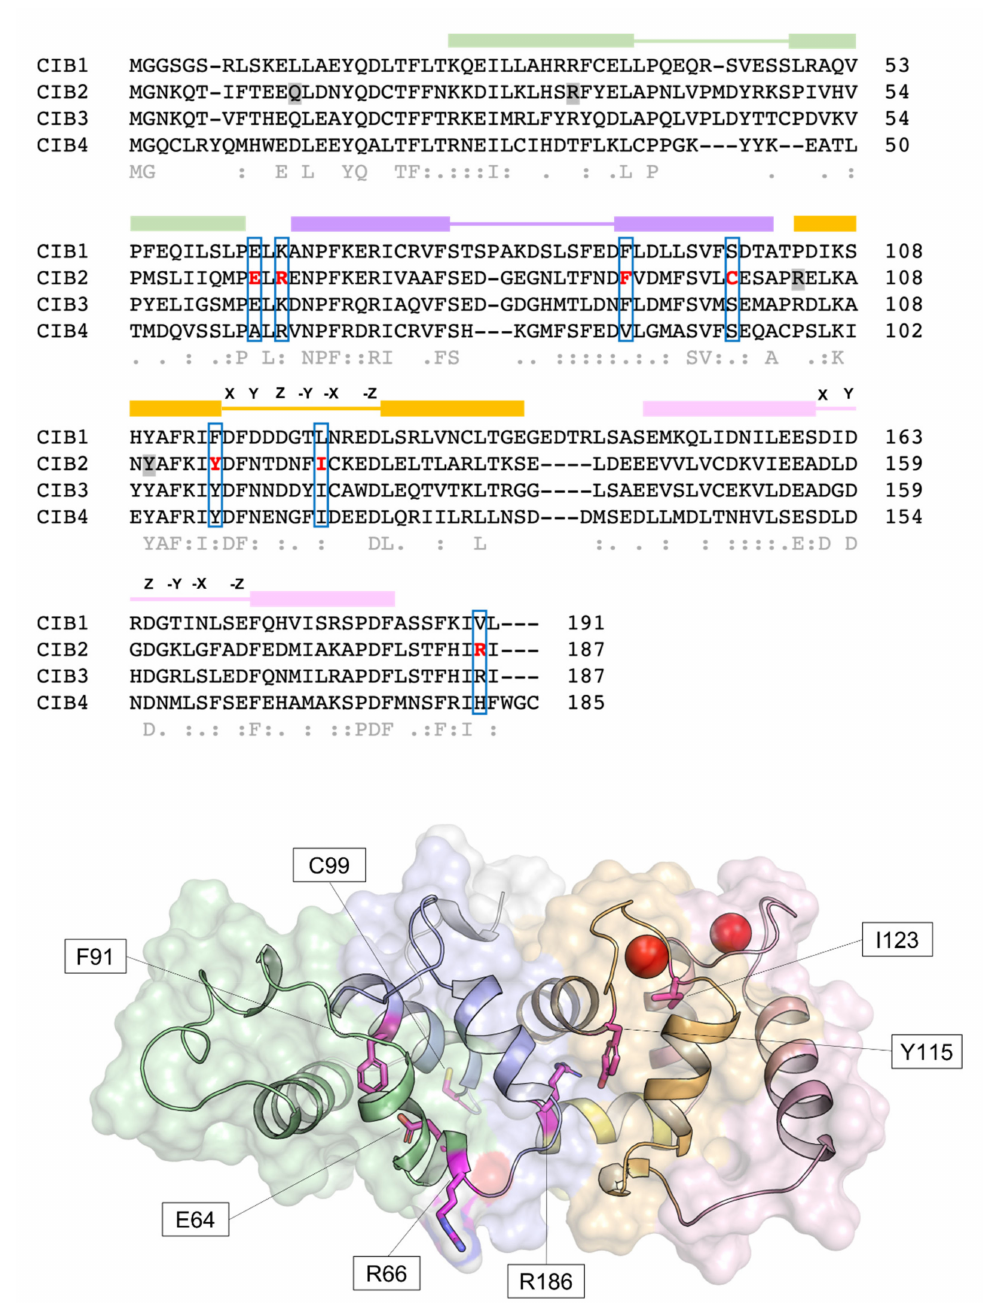
Figure 1. Sequence and structural properties of CIB2 and its pathogenetic variants. Top: multiple amino acid sequence alignment of human CIB1, CIB2, CIB3, and CIB4 performed by T–Coffee (https://tcoffee.crg.eu/apps/tcoffee/index.html, accessed on 22 February 2022). Consensus sequence and similarity descriptors are reported in grey text. Residues target of pathogenetic point mutations are grey-shaded in case of nonsense mutations or marked in red and blue-boxed in case of missense mutations (see Section 4.3). EF-hand motifs are displayed by colored boxes, and residues involved in Ca 2+ -coordination are indicated by letters referring to the canonical pentagonal bipyramidal geometry on the respective loops. Bottom: Representation of the three-dimensional structure of human CIB2 based on the homology model used in [14]. Cartoon and surface representation are superposed. The N-terminal region is colored gray, while the C-terminal region (helix 10) is colored yellow. EF1, EF2, EF3, and EF4 are colored green, slate blue, orange, and pink, respectively. Residue targets of pathogenic missense mutations are represented by magenta sticks, and Ca 2+ ions are represented by red